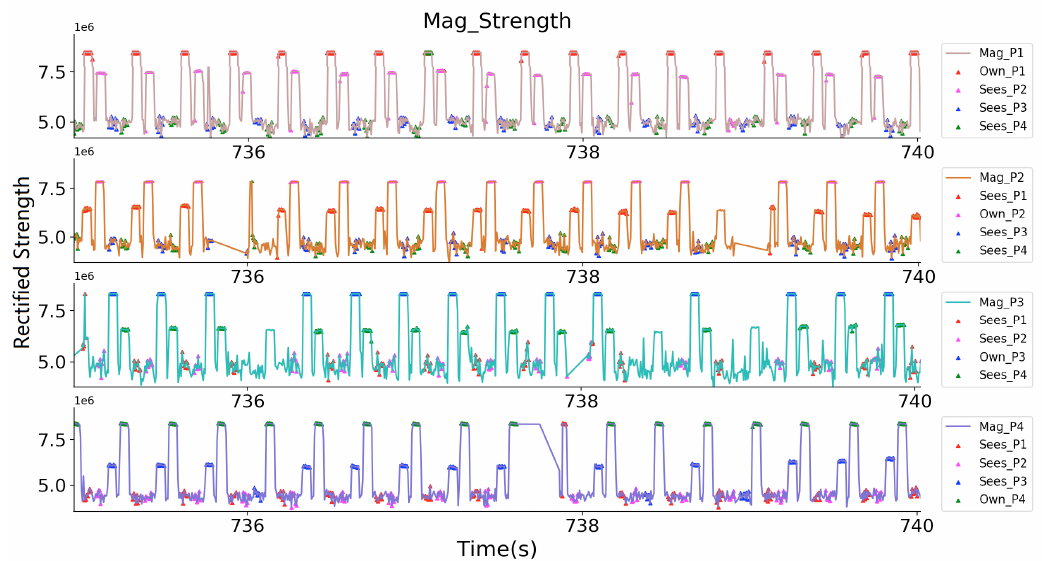
Figure 21. Four Volunteers’ receiver sampled rectified magnetic field strength signal, where they can see only another volunteer in their